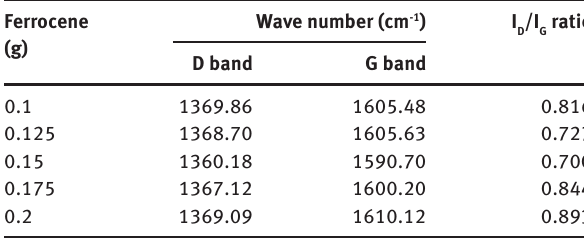
Table 1: Data extracted from Raman